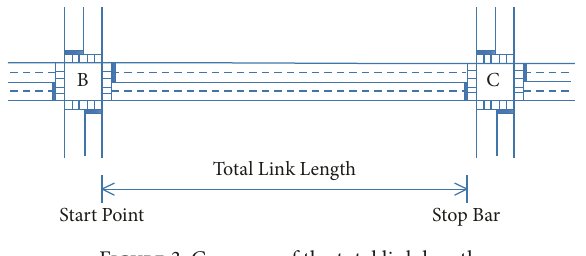
Figure 3: Coverage of the total link length.